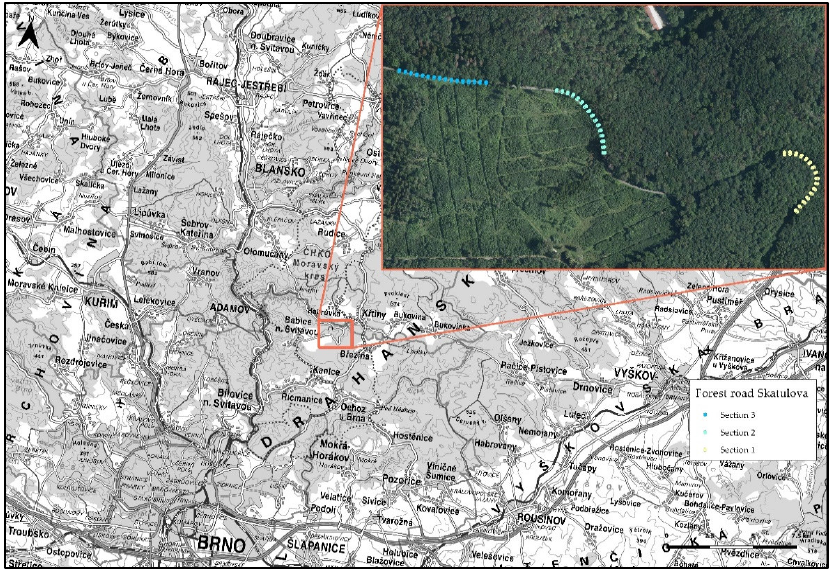
Figure 1. The study area—forest road “Skatulova” located in the Training Forest Enterprise “Masaryk Foresk” Křtiny.